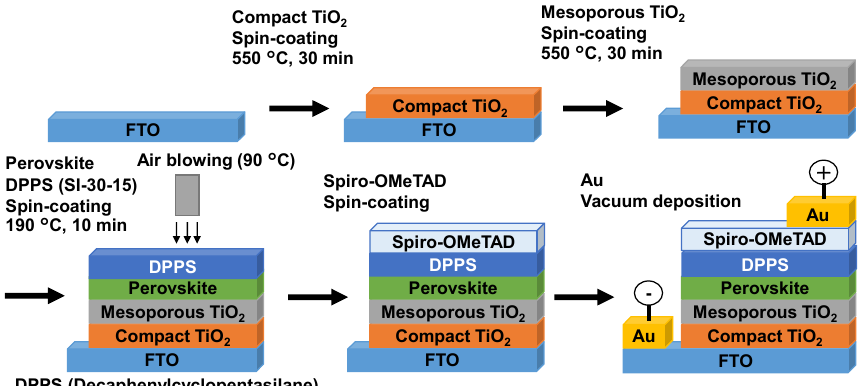
Figure 1. Schematic illustration for the fabrication process of the present photovoltaic cells.